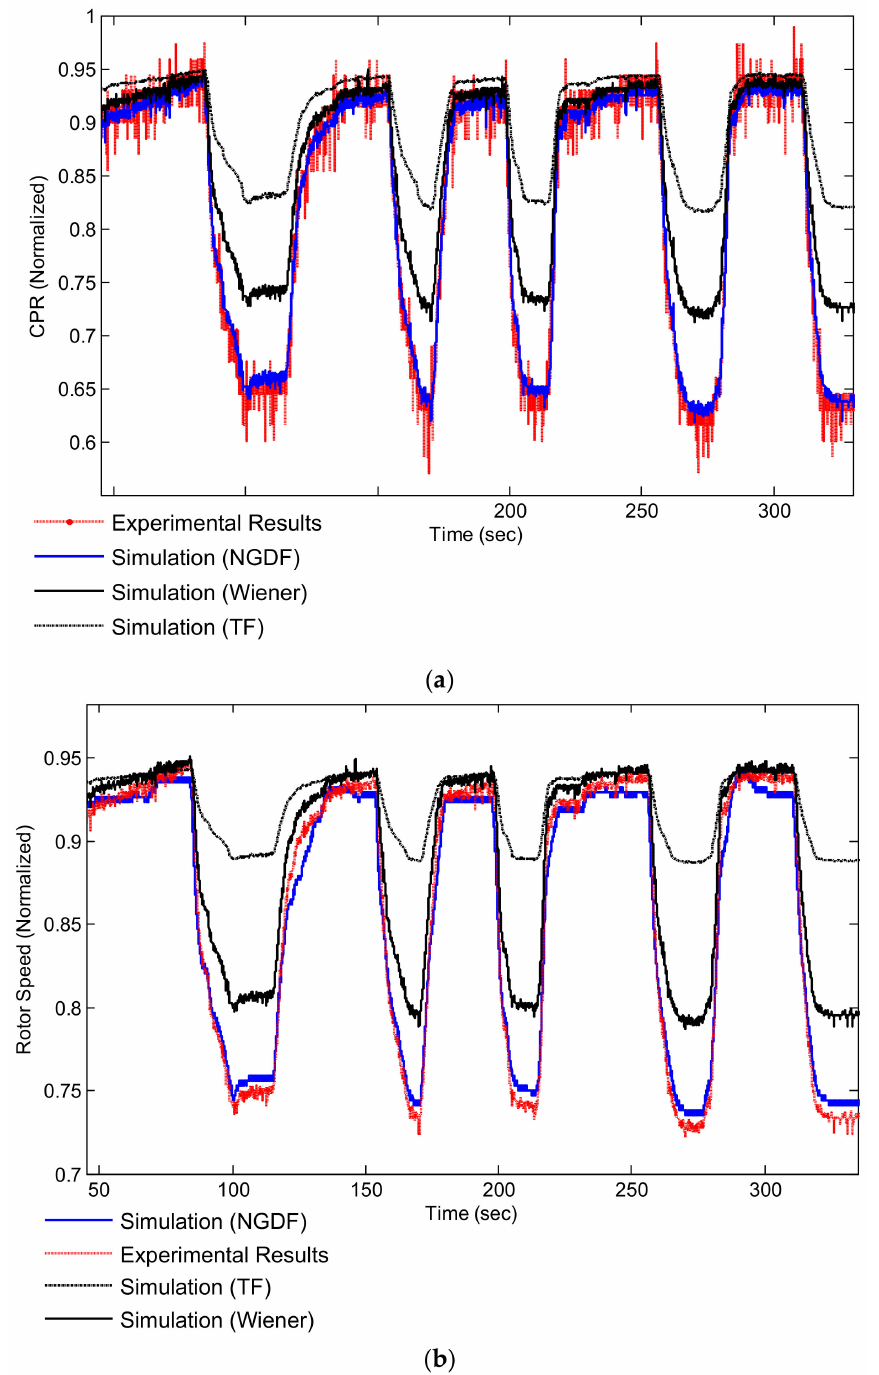
Figure 15. Modelling a turbojet engine with different reduced-order approaches: ( a ) normalized compressor pressure ratio (CPR) tracking; ( b ) normalized rotor speed